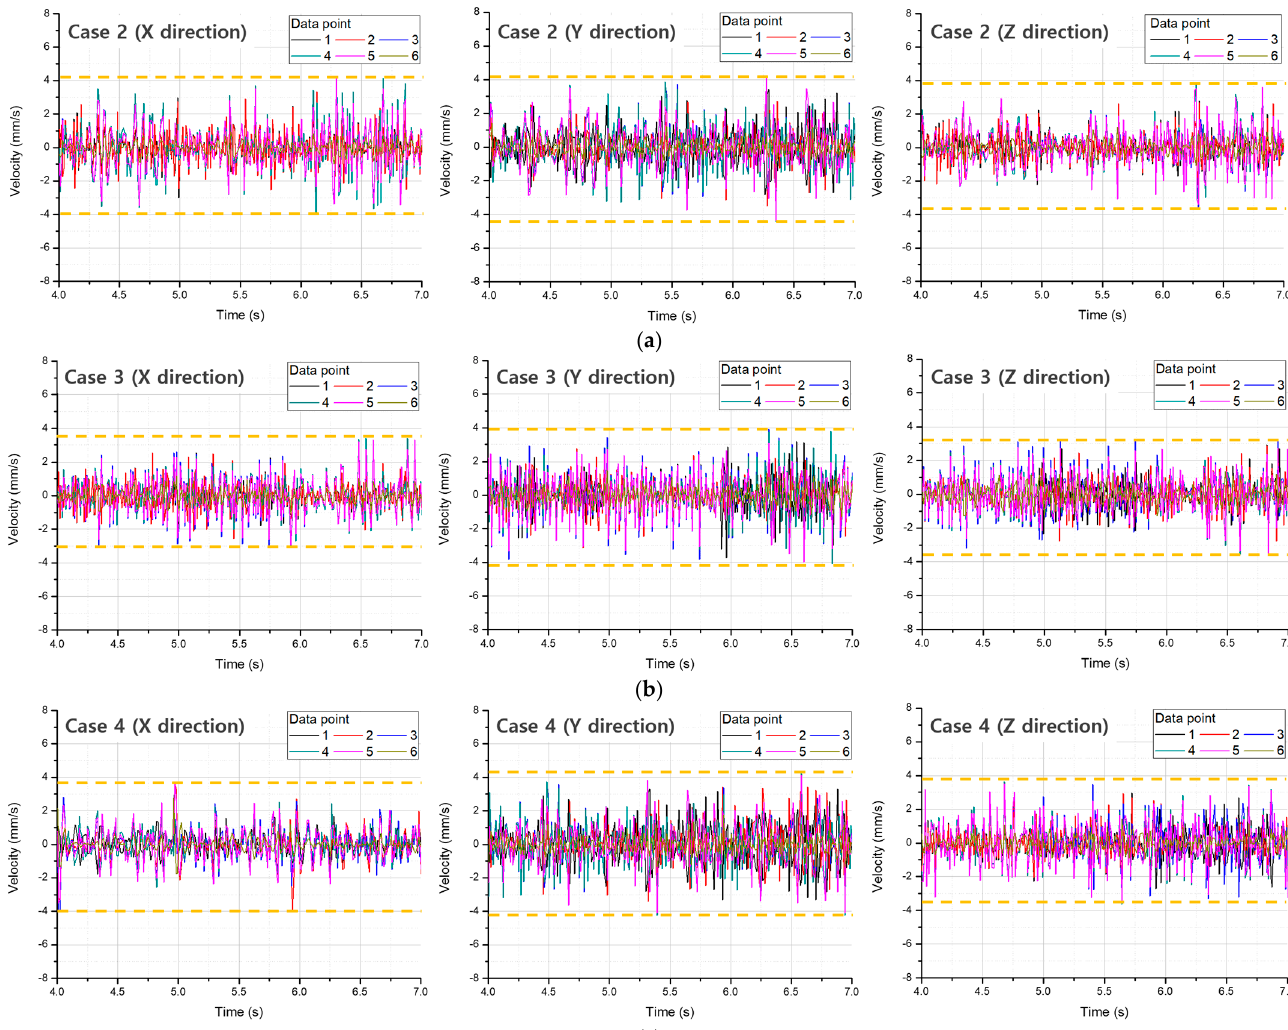
Figure 12. Vibration velocity according to the axial direction: ( a ) Case 2; ( b ) Case 3; ( c ) Case 4.